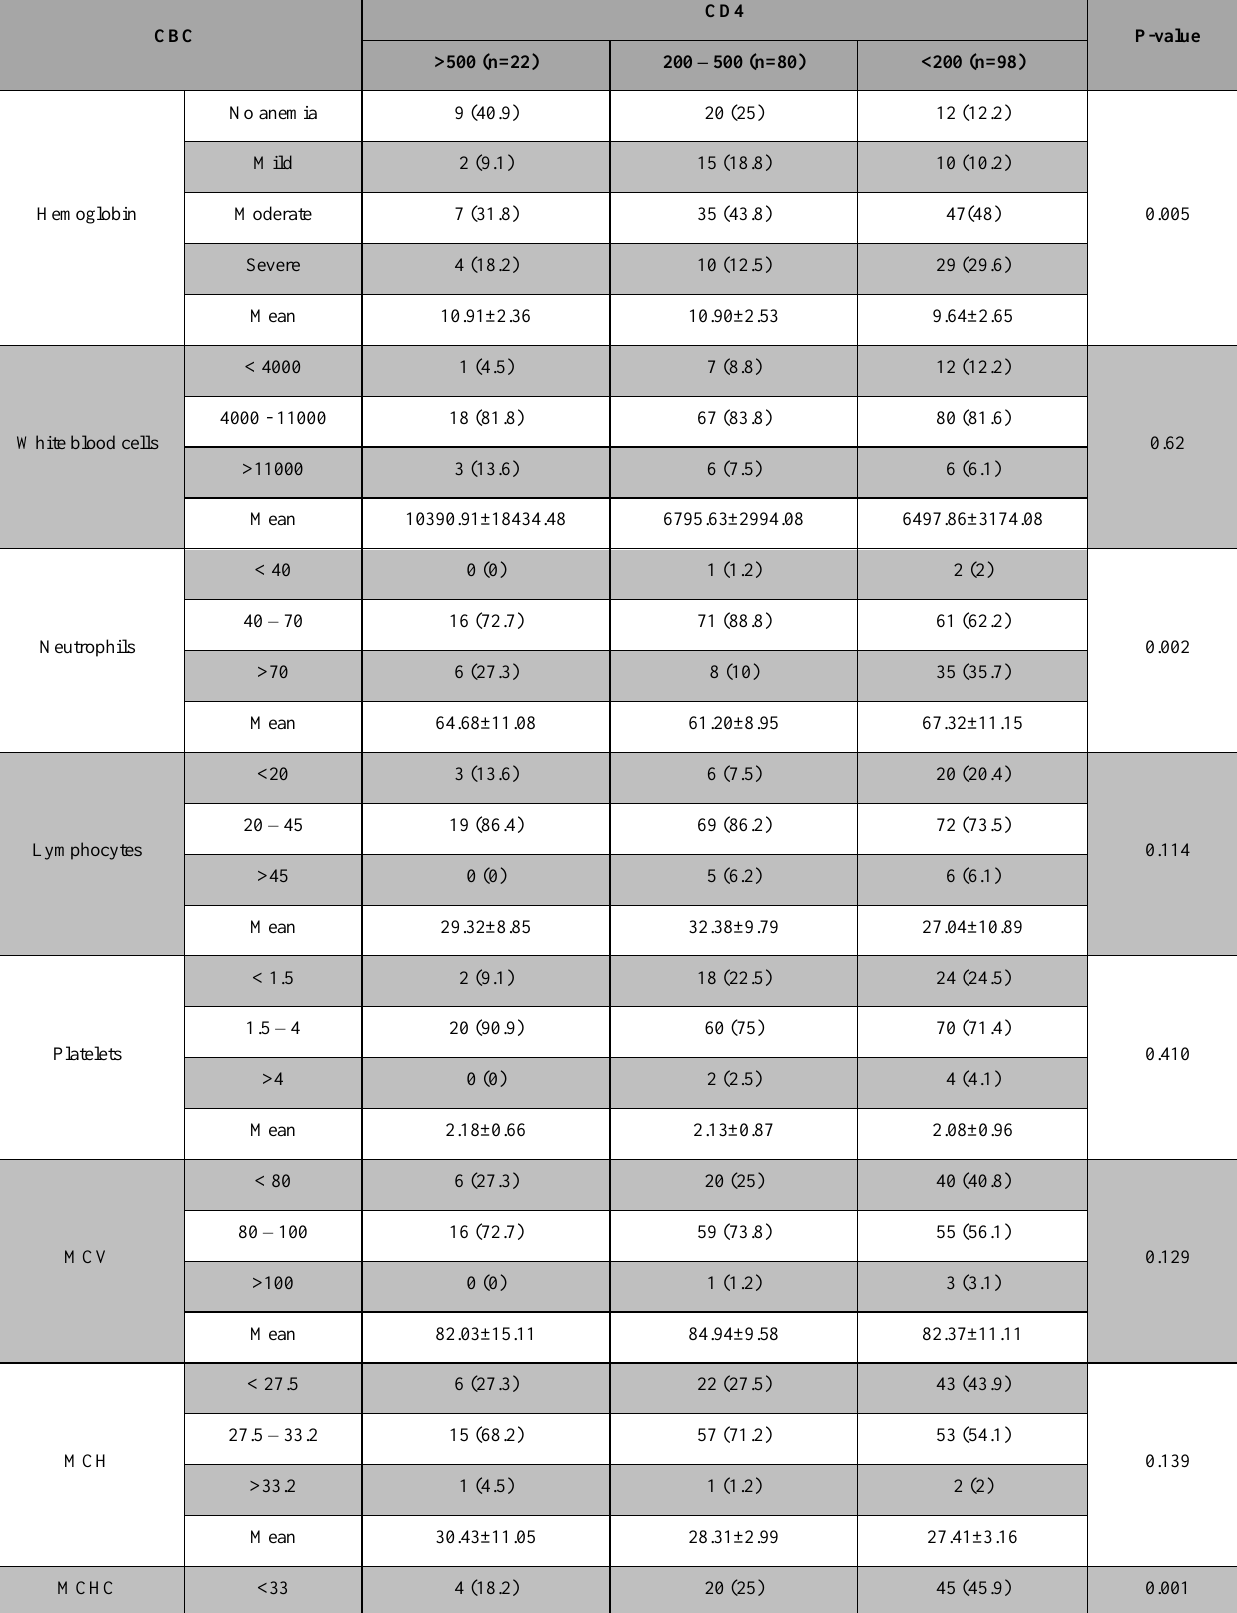
Table 3. Association of CD4 count with